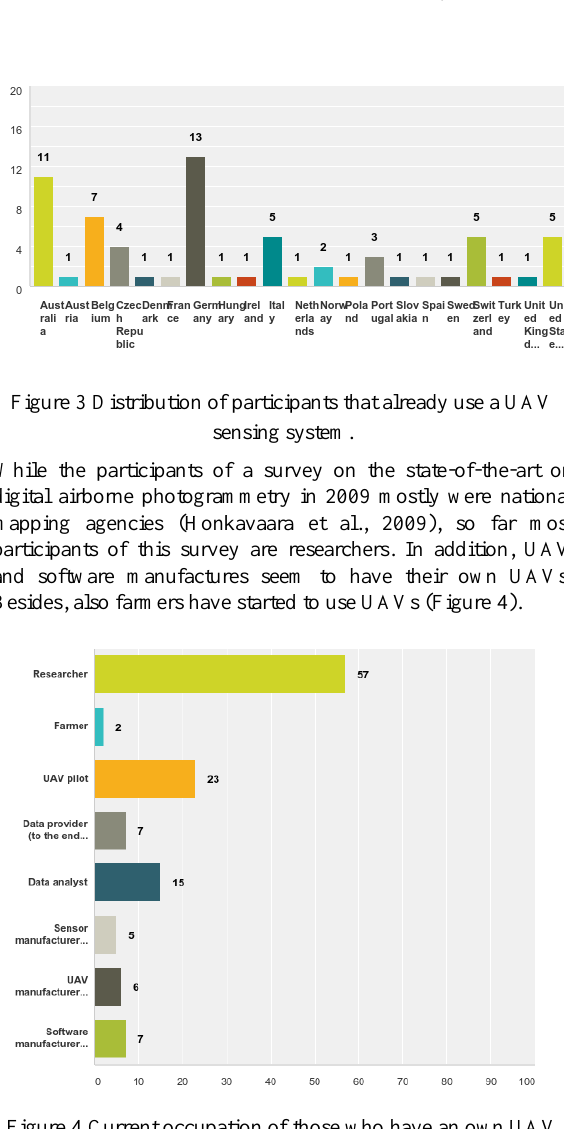
Figure 4 Current occupation of those who have an own UAV sensing system (multiple answers